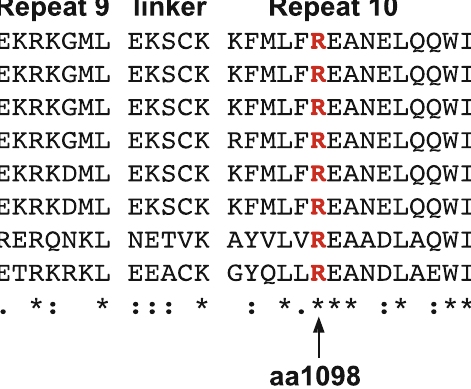
Figure 1. Relationship of the R1098Q variant to αII spectrin structure. ( a ) Schematic representation of αII spectrin with 20 complete homologous repeats each ≈ 106 residues and the location of selected functional domains that interrupt the repeat motif. The 9th and 10th repeats (red and purple respectively) harbor an inserted SH3 domain, a variably appearing alternative transcript insertion, and specialized sequences encompassing the site of CaM binding and the site Y1176 and G1177 that is preferentially cleaved by calpain. ( b ) Sequence of repeats 8–11 aligned by homology. The boxes denote the boundaries of each of the three α-helices (A–C) of the canonical repeat unit; these are separated by AB and BC loops and inter-unit linkers. The sequences representing the SH3 domain and the alternative transcript inserted into repeat 9 and the calpain and CaM interaction sites in repeat 10 are indicated. The arrow marks the site of the R1098Q mutation near the start of the 10 th repeat. The YG site of preferred calpain cleavage is colored green. ( c ) Clustal alignment of residues flanking the R1098Q mutation. This locus, and the flanking region, is almost perfectly conserved across diverse species. Residues fully conserved are denoted with asterisks (*); residues strongly conserved with a score greater than 0.5 on the PAM250 matrix are designated with a colon (:). Weakly similar residues are denoted with a period